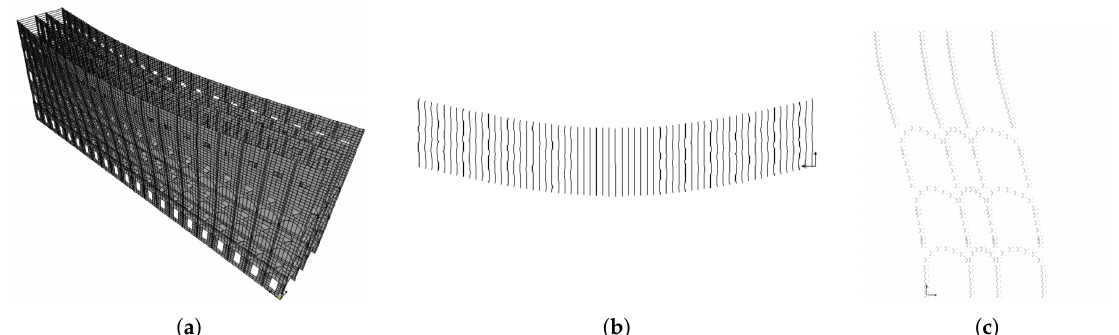
Figure 15. First natural mode of the LW fine model. Natural frequency f = 0.54 Hz. Modal shape in the: ( a ) 3D space; ( b ) x − z plane; ( c ) y − z plane.